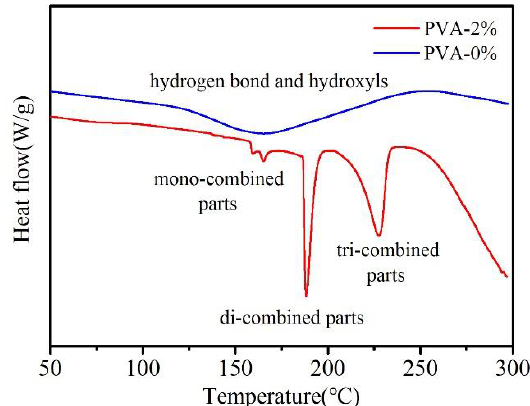
Figure 3. DSC curves of freeze-dried pure PVA and PVA containing 2.0% of ferric ions.